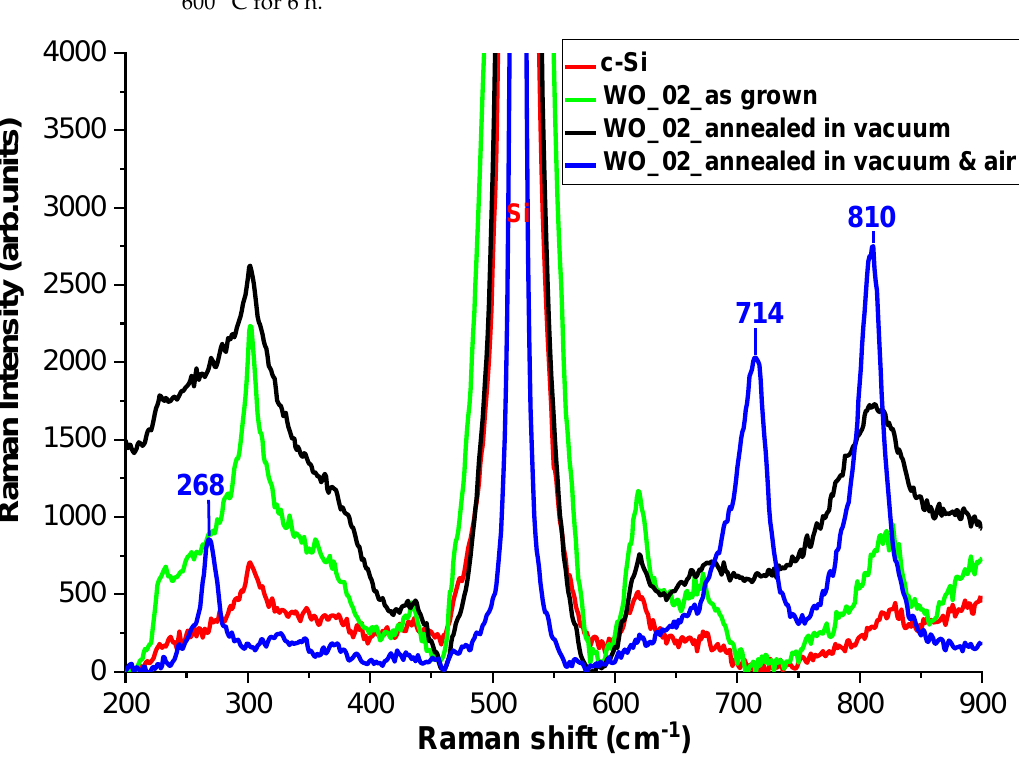
Figure 12. Comparison between Raman spectra obtained on as-grown WO_02 and the annealed sample.